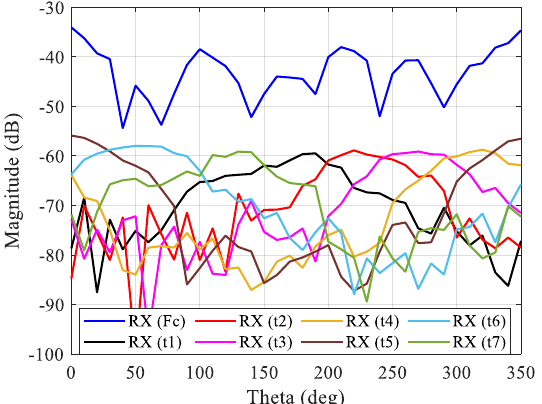
Figure 9. OTA multi-sine characterization to identify the contribution of each antenna element for case C (lower band).